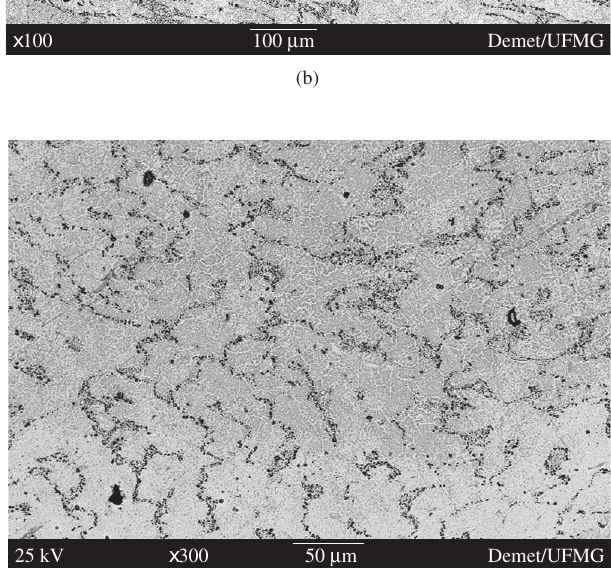
Figure 6. Microstructure of Pb-Sb alloy after 8 passes of